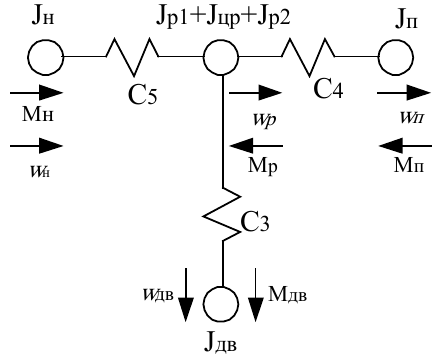
Figure 5. Design diagram of the empty